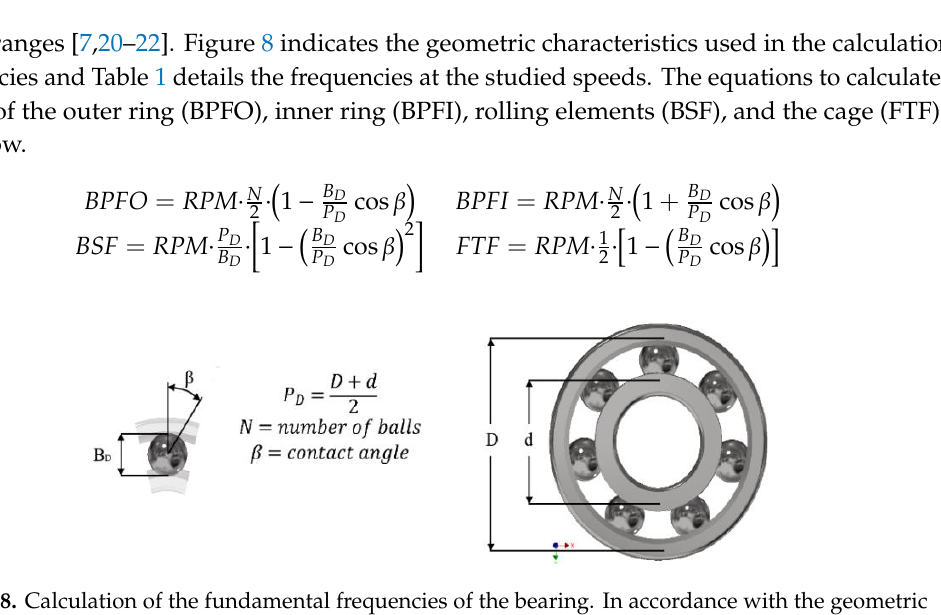
Figure 8. Calculation of the fundamental frequencies of the bearing. In accordance with the geometric characteristics of the bearing used, a table of the frequencies of each component, for different rotating regimes is shown below. These frequencies have been taken from the official Schaeffler webpage. Table 1. Fundamental frequencies of the 22205E1KC3 bearing at different regimes.